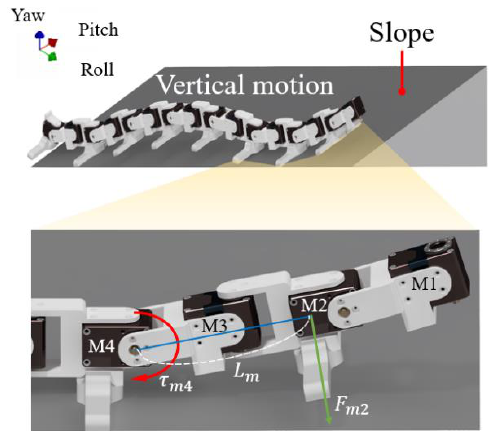
Figure 4. Configuration for dynamic modeling of the snake robot with a DAM.